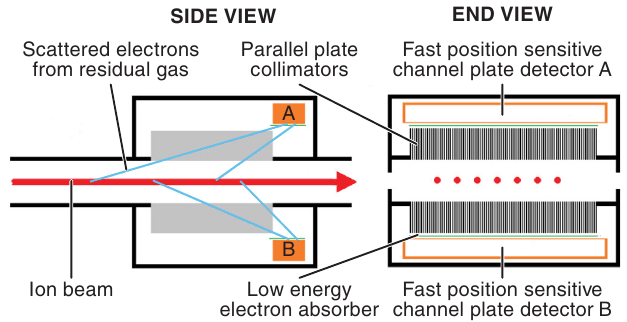
FIG. 23. Concept of one of the possible approaches to detect several side-by-side orbits in one of the fixed-field alternating gradient (FFAG) arcs of the electron-ion collider, eRHIC, which will be proposed as a successor to RHIC. Fast, position-sensitive channel-plate detectors respond to energetic electrons collimated by parallel plate collimators (see